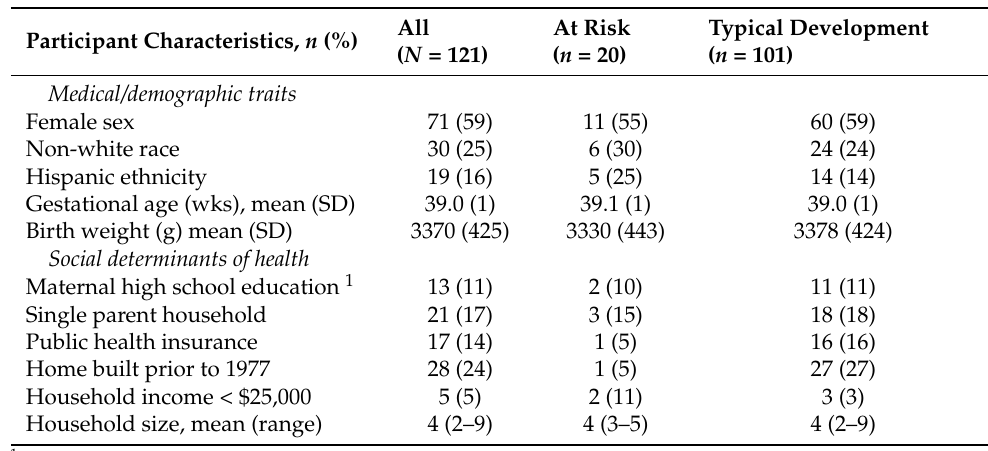
Table 1. Participant characteristics.